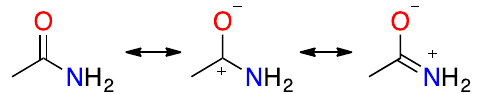
Figure 1. The interaction between the nitrogen highest occupied molecular orbital (HOMO) and the carbonyl lowest unoccupied molecular orbital (LUMO) in amides.